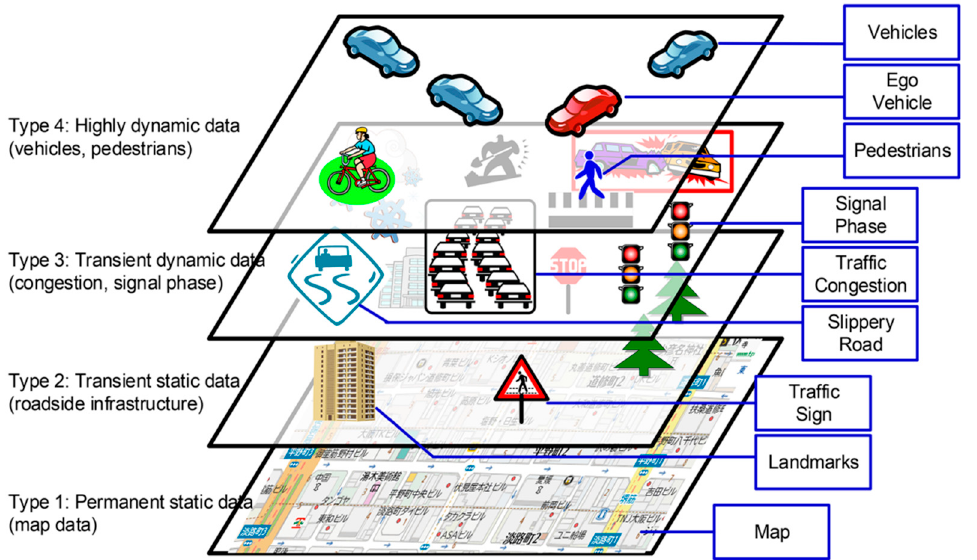
Figure 1 . LDM layer structure [2]. Figure 1. LDM layer structure. (Reprinted from Ref.